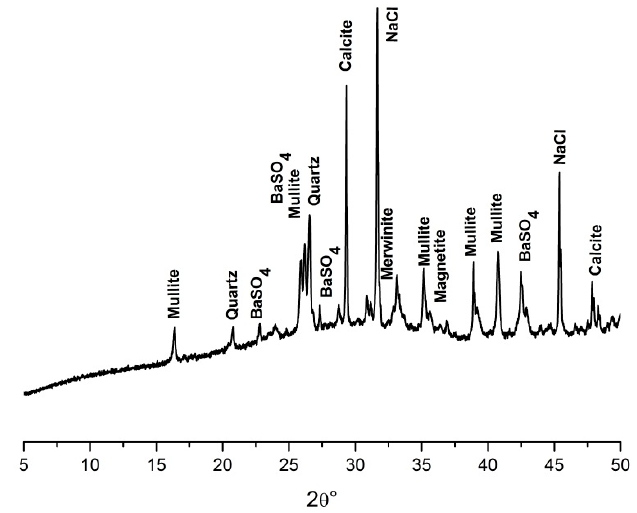
Figure 8. X-ray powder diffraction (XRD) patterns of the alkali-activated material (AAM) matrix with heavy metals.